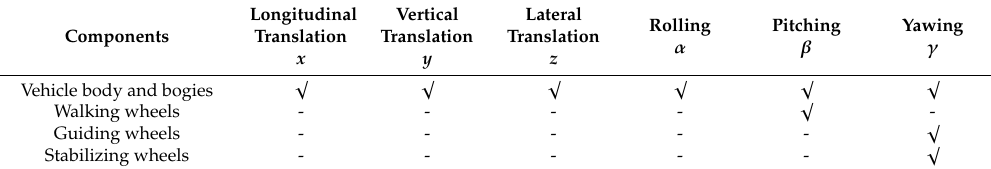
Table 1. Degrees of Freedom (DOFs) of a straddle-type monorail